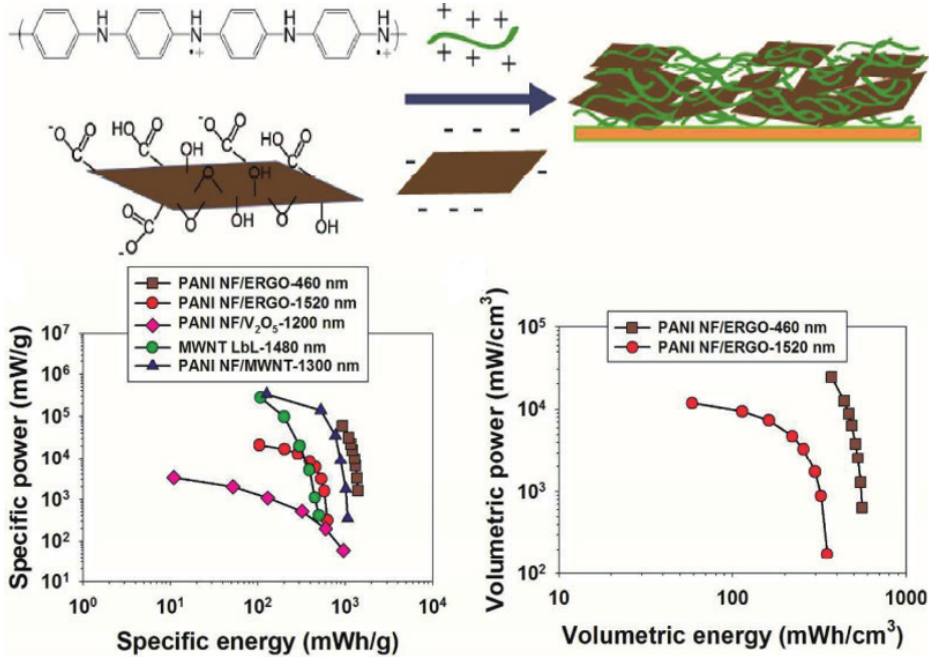
Figure 3 - Illustration of a LbL assembly of PANI-NFs and GO sheets (top). Ragone plots based on mass (left) and volume (right) of the different PANI NF-based LbL films (bottom). Modified with permission from Jeon and et al. (2015). Copyright 2015 Royal Society of